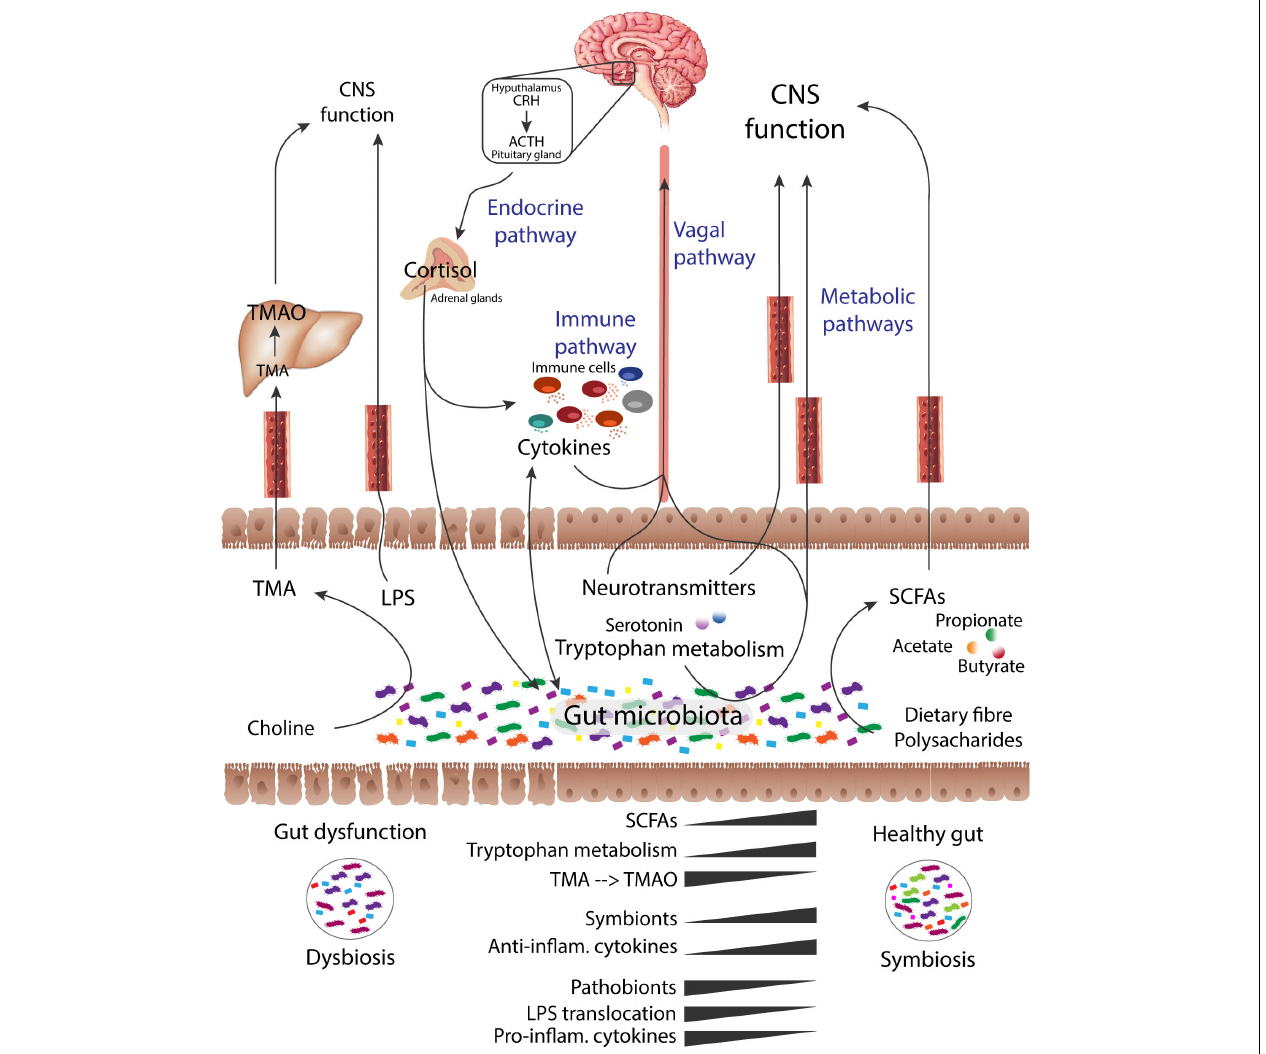
FIGURE 3 | Endocrine, immune, metabolic and vagal direct and indirect pathways for bidirectional communication of the gut-brain axis. Changes in the bacterial abundances and development of gut dysfunctional state (dysbiosis) impacts host and Central Nervous System (CNS) functions, often associated to disease. Consequently, there is a shift in microbial-derived products. Short-chain fatty acids (SCFAs), derived from the microbial digestion of dietary fiber, play a crucial role in the regulation of microglia and brain immune responses. The production of SCFAs, neuroprotective biochemicals essential to host metabolism, is compromised under a state of intestinal dysbiosis, which impacts the CNS function. Increased levels of Trimethylamine N -oxide (TMAO), a gut microbial-mediated metabolite, has been linked to aging and cognitive impairment. The microbial metabolism of tryptophan, leading to the production of, for instance, the neurotransmitter serotonin, is also compromised under dysbiotic states. On the other hand, stress at the CNS level can impact intestinal function and promote gut microbial perturbations. Thus, the CNS is capable of recruiting the same mechanisms to modulate the gut microbial composition, such as by the stimulus of cortisol secretion. Cortisol can have an influence on immune cells recruitment and cytokines secretion, as well as on the epithelial barrier permeability. Compromised integrity of the gut epithelial barrier allows the translocation of overgrowth pathobionts and neurotoxic microbial fragments, such as lipopolysaccharides (LPS), which can later reach and cross a compromised blood-brain barrier. The microbes and their secreted metabolites shape the host-immune system and vice-versa. A dysbiotic intestinal microbiota can hijack the host-immune system and modulate the inflammasome signaling. Note: figure was adopted from references (Grenham et al., 2011; Cryan and Dinan,